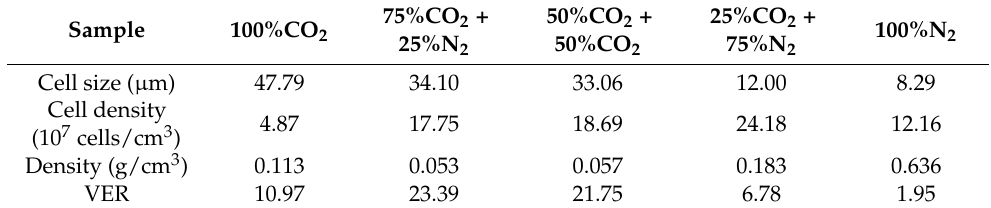
Table 4. Cell parameters of PPCE-1.2 samples under different gas conditions.